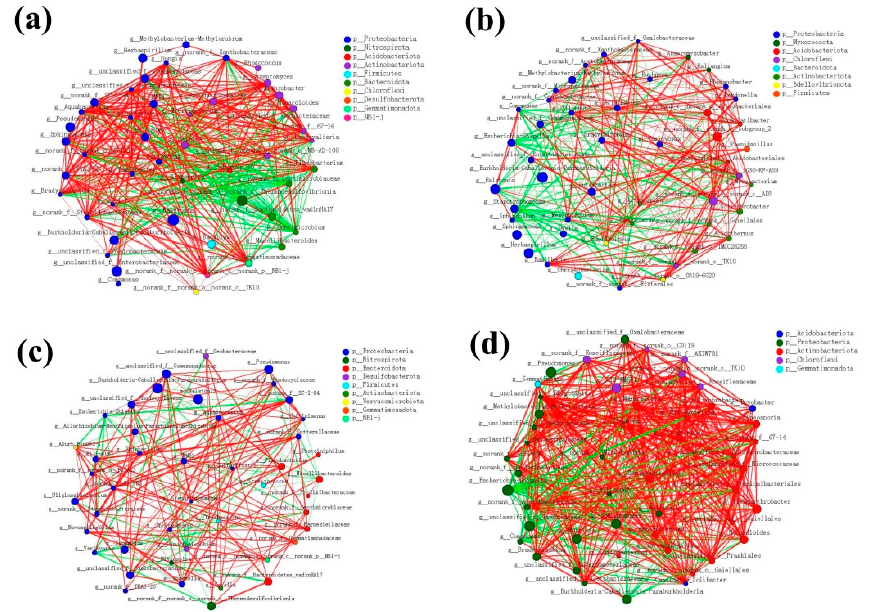
Figure 8. The networks of dominant microbiota at the genus level (top 50) in CS ( a ), LY ( b ), ZZ ( c ), and DY ( d ). The size of the nodes shows the abundance of OTUs, and the different colors indicate the corresponding taxonomic assignment at the phylum level. The edge color represents positive (red) and negative (green) correlations. The edge thickness indicates the correlation values; only significant interactions are shown (r > 0.6; p < 0.05).